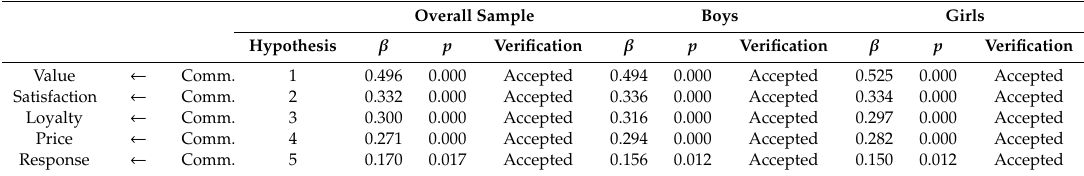
Table 5. Comparison between the standardised regression coe ffi cients and hypothesis